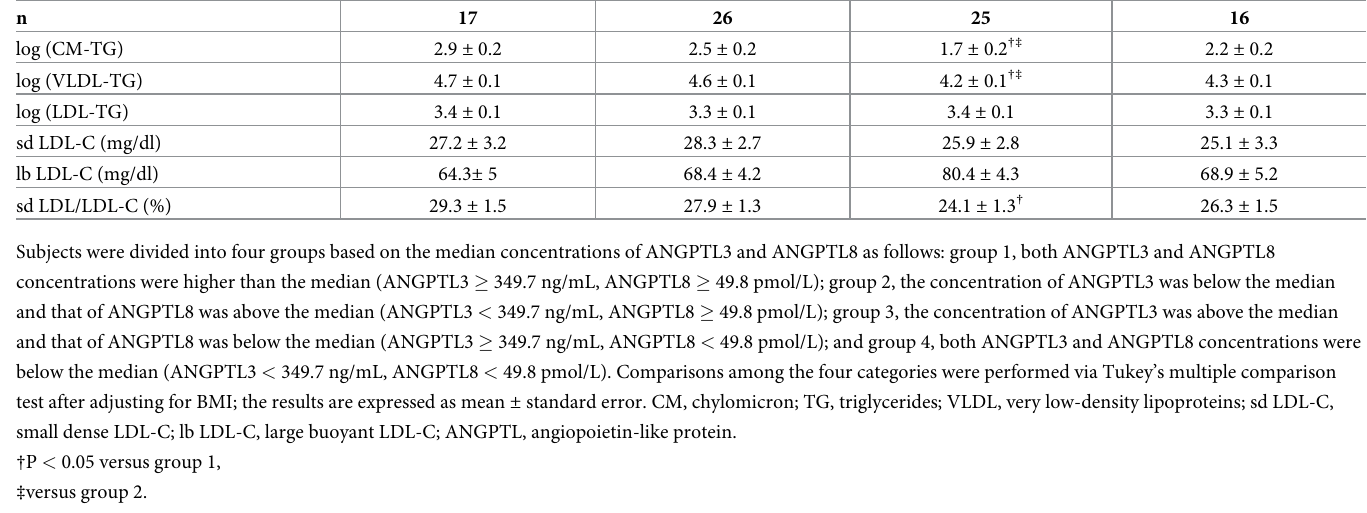
Table 4. The relationship between lipid profiles and the four groups created using the median concentrations of ANGPTL3 and ANGPTL8. Group 1